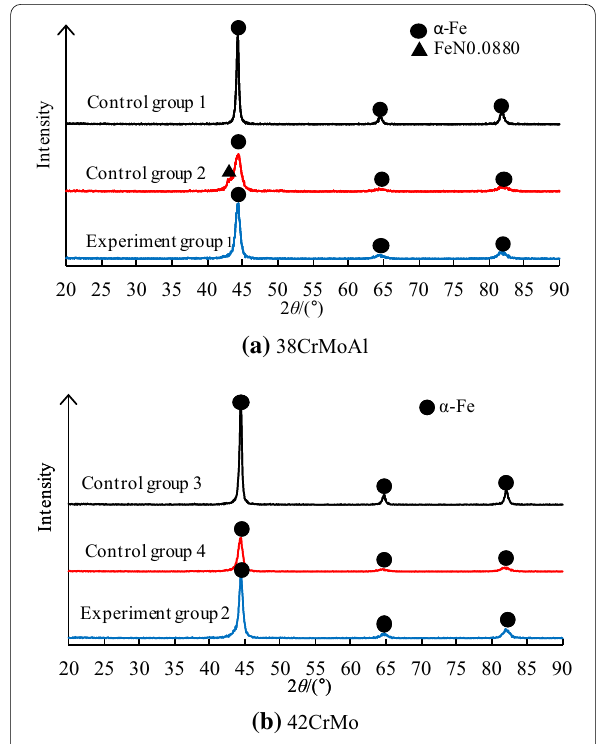
Figure 3 XRD diffraction pattern of the lower